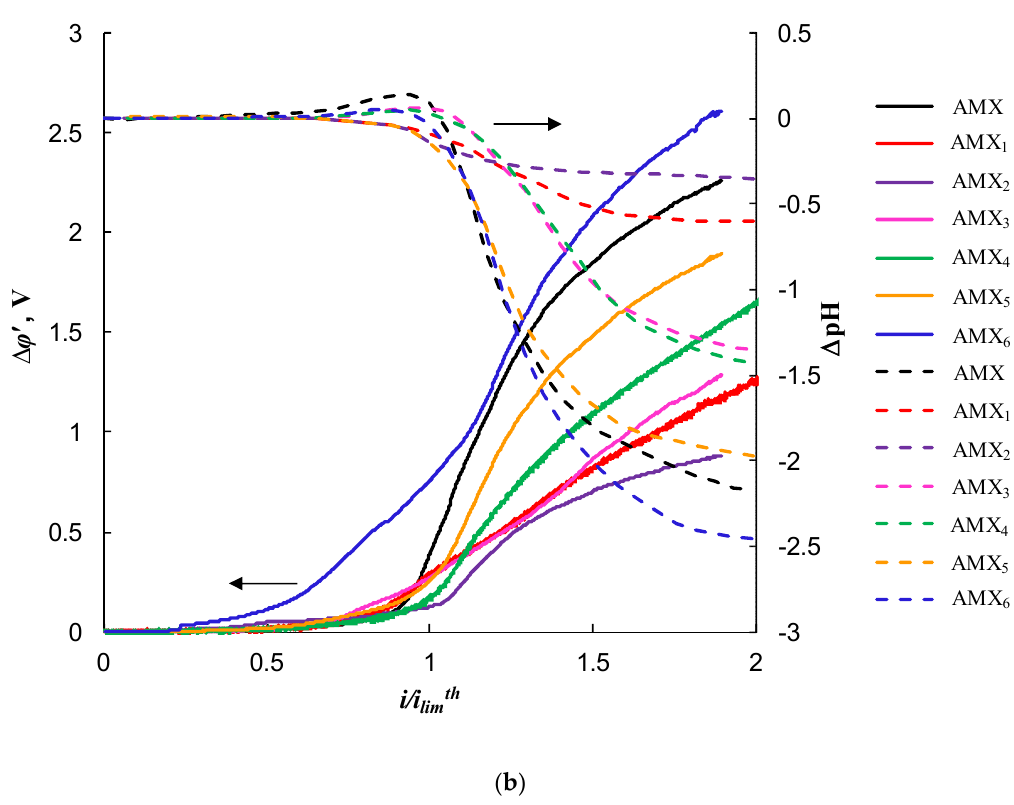
Figure 10. Current–voltage characteristics (solid lines) and the difference in pH between the outlet and inlet solution passing through the desalination compartment of the electrodialysis cell (dashed lines) of the pristine and modified AMX-Sb ( a ) and AMX ( b ) membranes